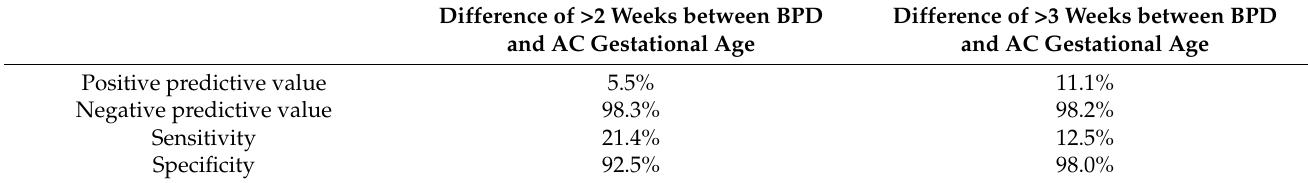
Table 4. Diagnostic performance for prediction of placental abruption.